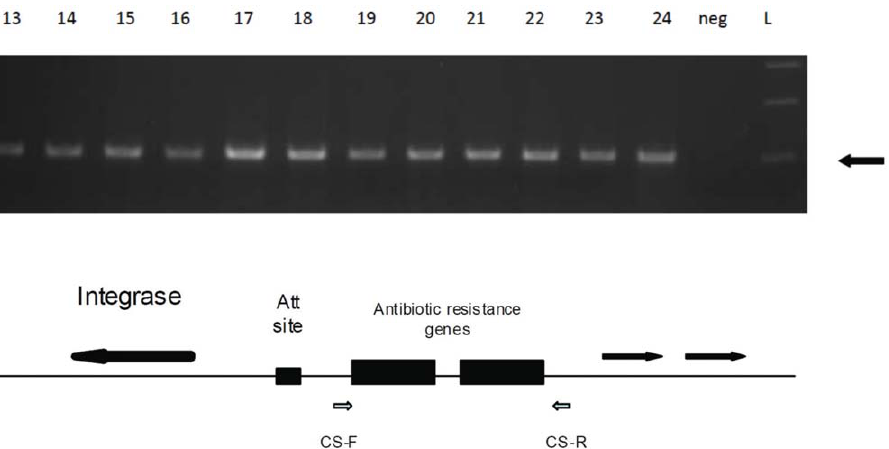
Figure 2. Integron Content in Select Study Isolates. Integron PCR gene products of WC 13–24 are shown. The block arrow marks the 550 base pair PCR product of the prevalent strain A. baumannii . The water control is labeled ‘‘neg.’’ The cartoon shows the layout of a typical Class I integron. The PCR primers are presented by CS-F and CS-R.